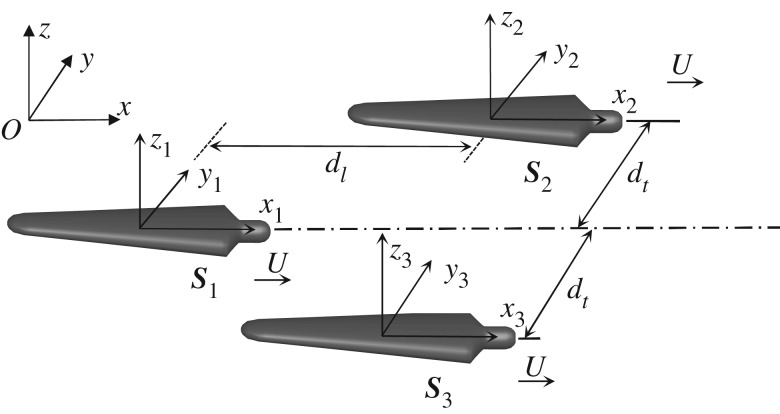
Coordinate systems.